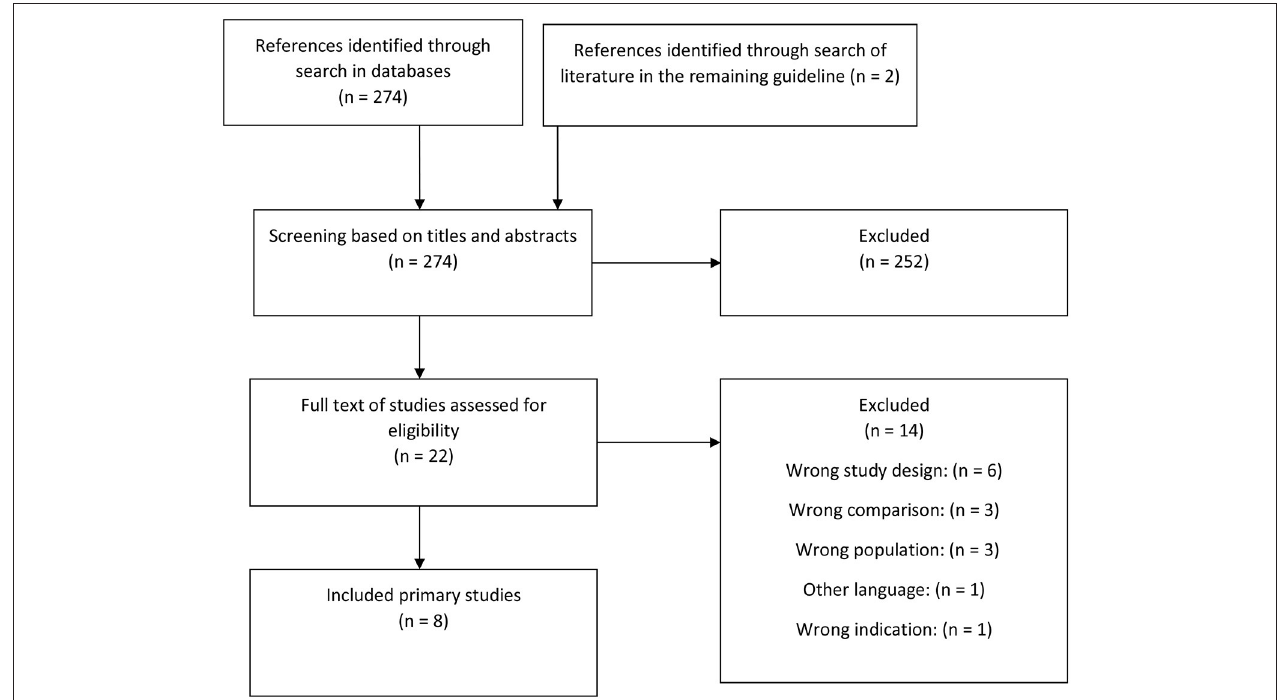
FIGURE 2 | Flowchart of primary